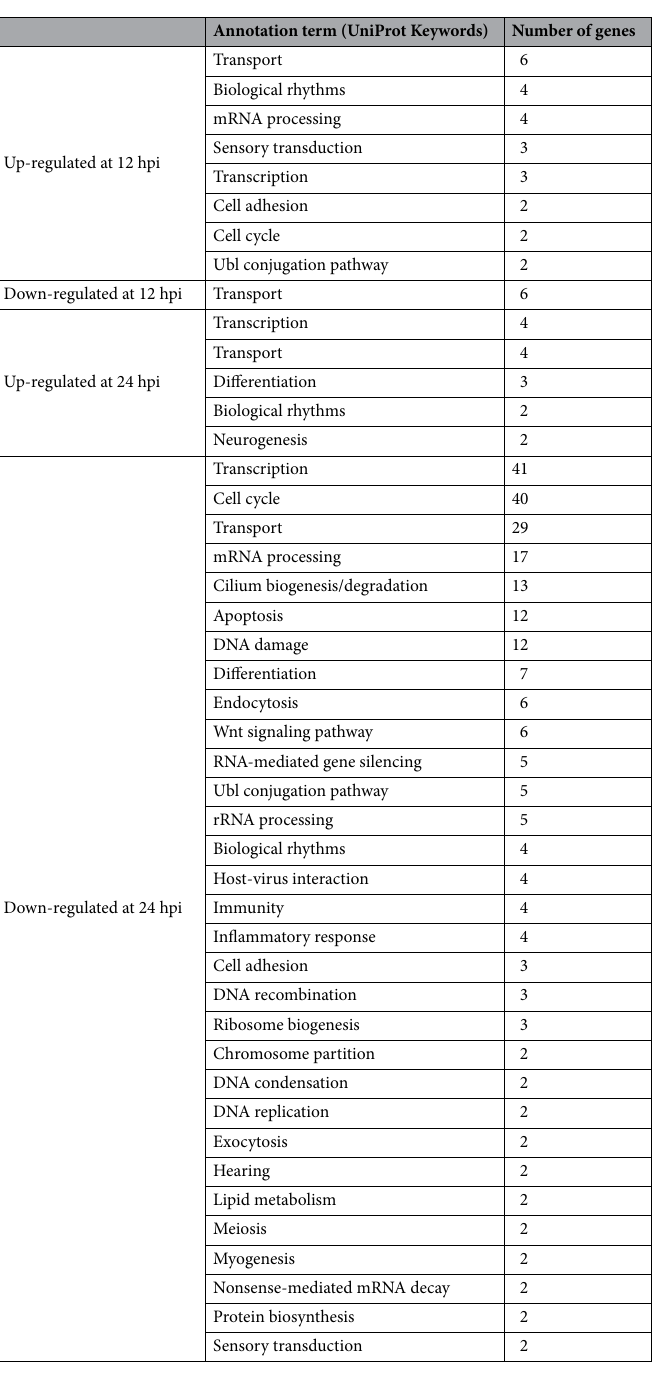
Table 2. Gene function categories (UniProt Keywords) of differentially expressed genes at 12 and 24 h post- inoculation in Smic-inoculated